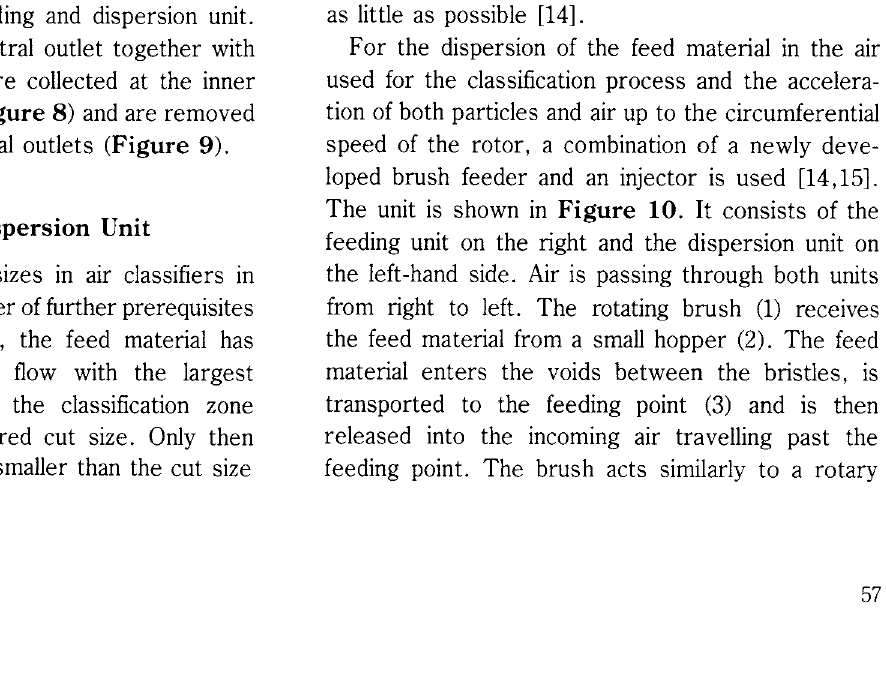
Fig. 9 Top view of the Clausthal Impeller Wheel